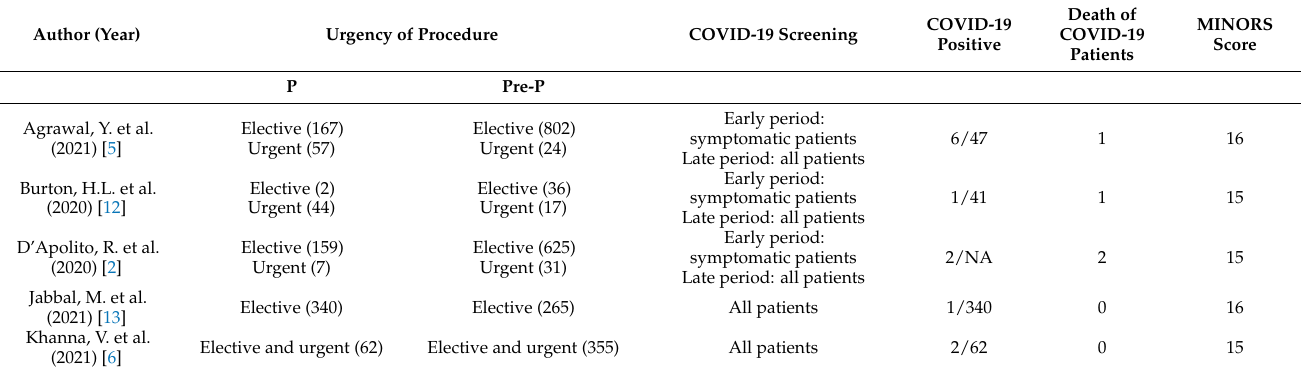
Table 3. Urgency of procedure, details regarding COVID-19, and MINORS